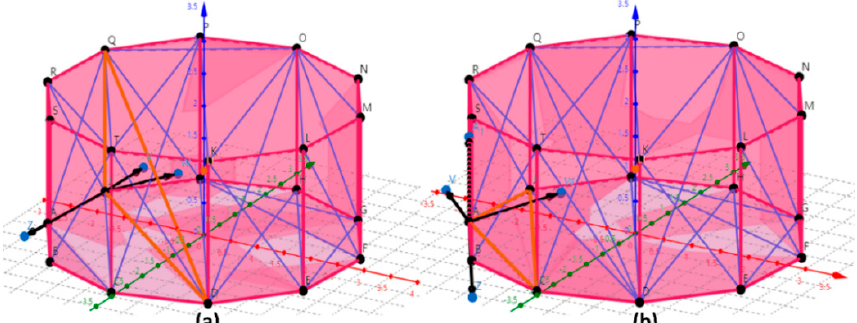
Figure 7. Merge or retain the triangles that make up the polyhedron. ( a ) The orange triangle QJD was merged; ( b ) orange triangle ACJ was retained. Black directed line segment represents three vectors (V, W, Z) and the orange dot U represents the center of the (V, W, Z) and the orange dot U represents the center of the polyhedron.